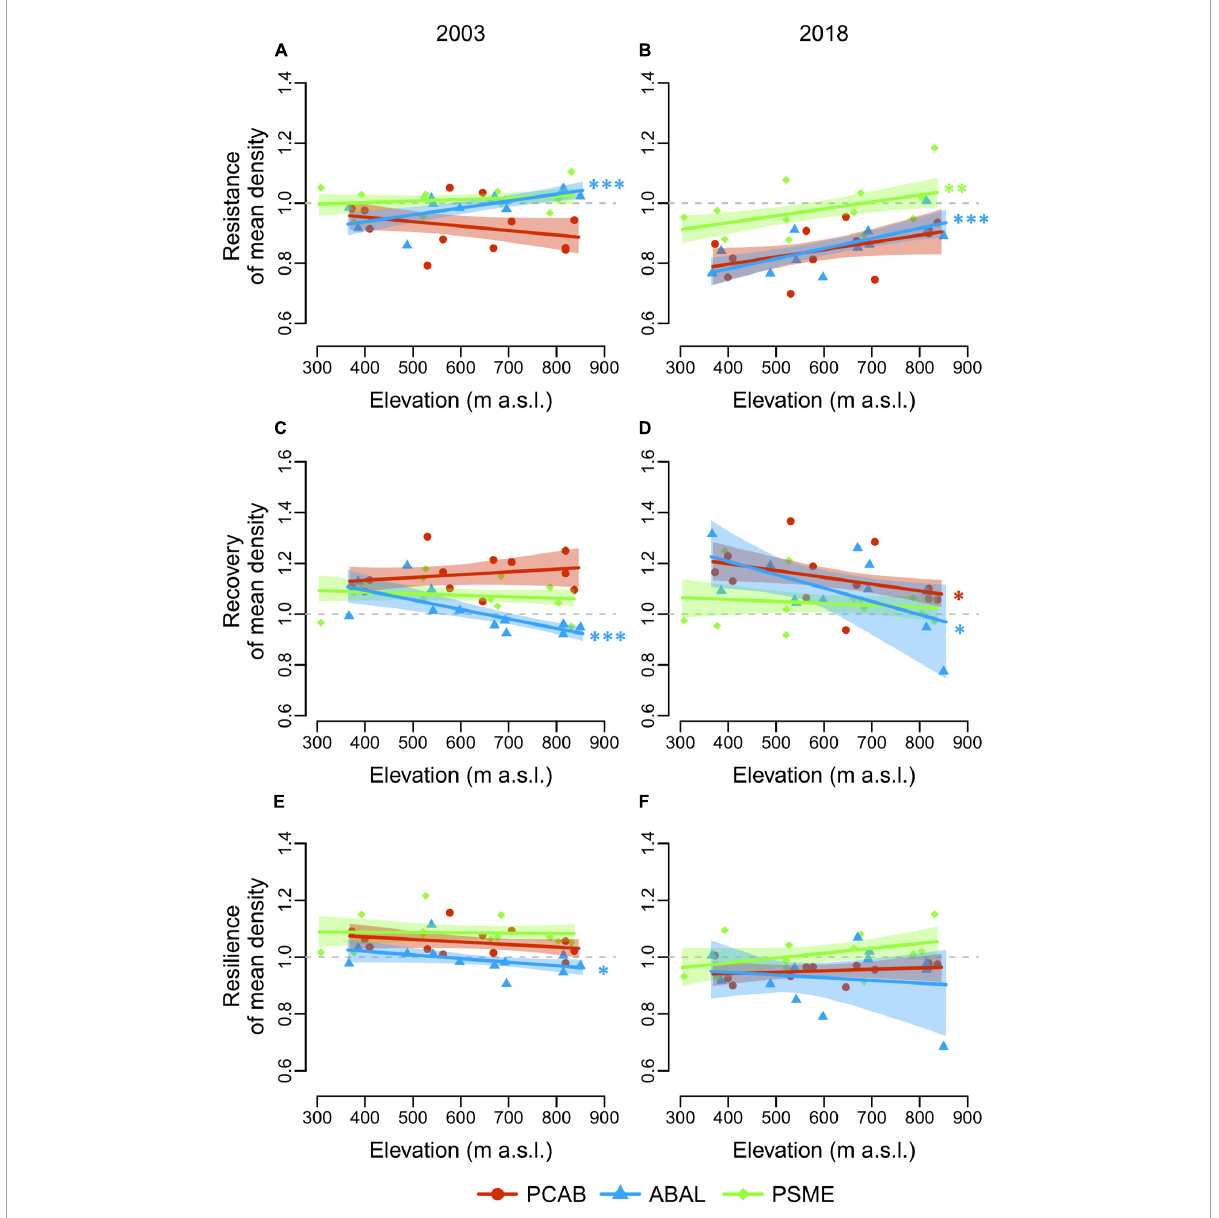
FIGURE4 Resistance (A,B) , recovery (C,D) and resilience (E,F) indices of mean tree-ring density of Norway spruce (PCAB), silver fir (ABAL) and Douglas fir (PSME) in response to elevation for the two extreme drought events of the years 2003 (left) and 2018 (right). Transparent ribbons indicate bootstrapped 95 % confidence intervals of predictions of linear mixed-effects models based on 10,000 replications. For illustration, data points were averaged on the stand level. Asterisks on the right side of the panels indicate if slopes of the regression lines are significantly different